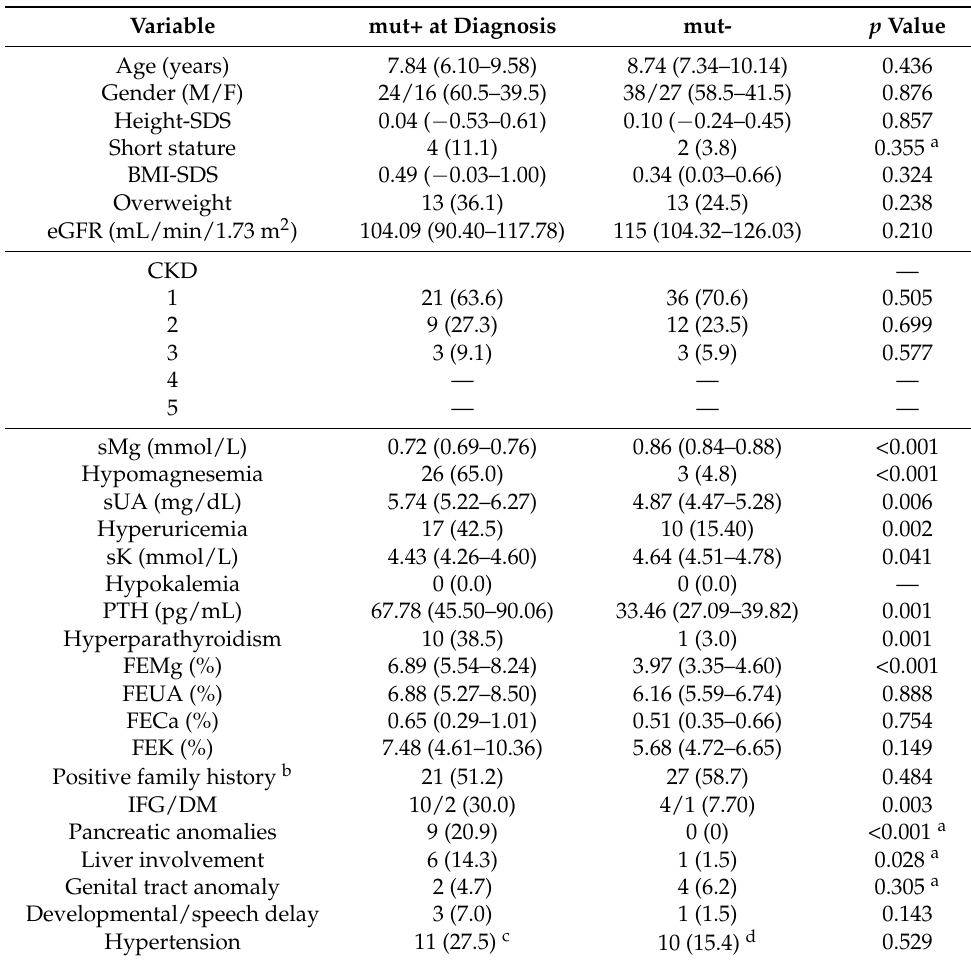
Table 1. Characteristics of the study cohorts.